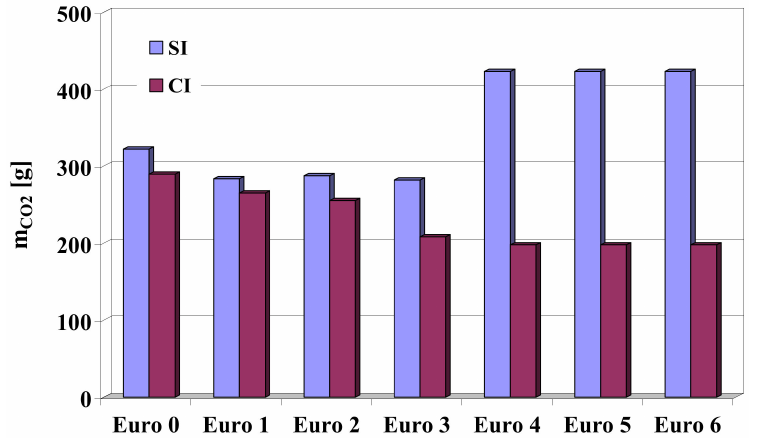
Figure 11. Additional emission of carbon dioxide—m CO2 , during warm-up of the spark-ignition engine—SI or the compression-ignition engine—CI of passenger cars of Euro 0–Euro 6 pollutant emission categories, under the model conditions for vehicle